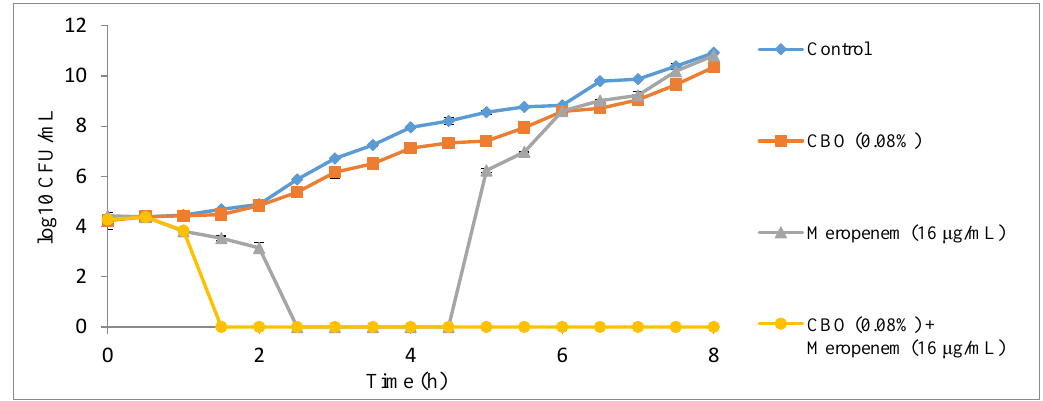
Figure 2. A 30-minute interval killing curve for CBO and meropenem alone, and in combination against K. pneumoniae BAA-1705.